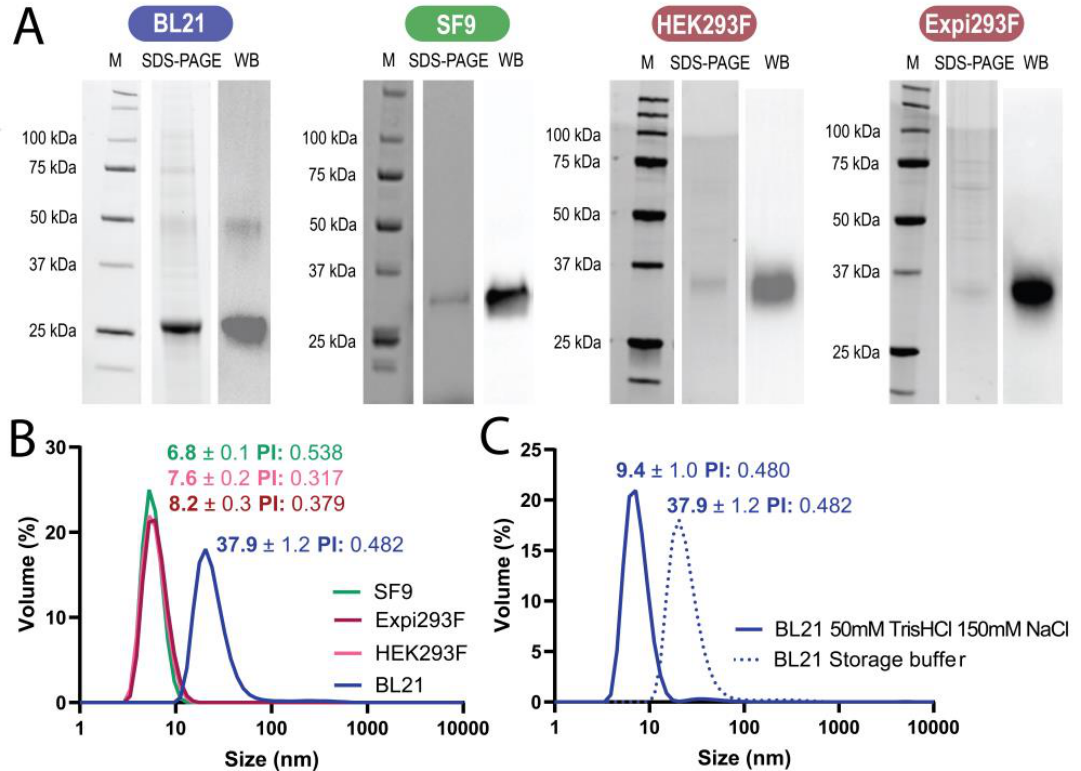
Figure 3. Comparative analysis of the protein products. ( A ) Electrophoretic analysis of the final protein products, including immunodetection using an anti-His antibody. ( B ) DLS plots of the purified proteins, to reveal their hydrodynamic size and polydispersity index (PI). ( C ) Disassembly of the bacterial product into protomers in low-salt buffer. In these conditions, the protein was unstable and tended to precipitate. Table 1. Protein yield and purity of the tested protein production platforms.